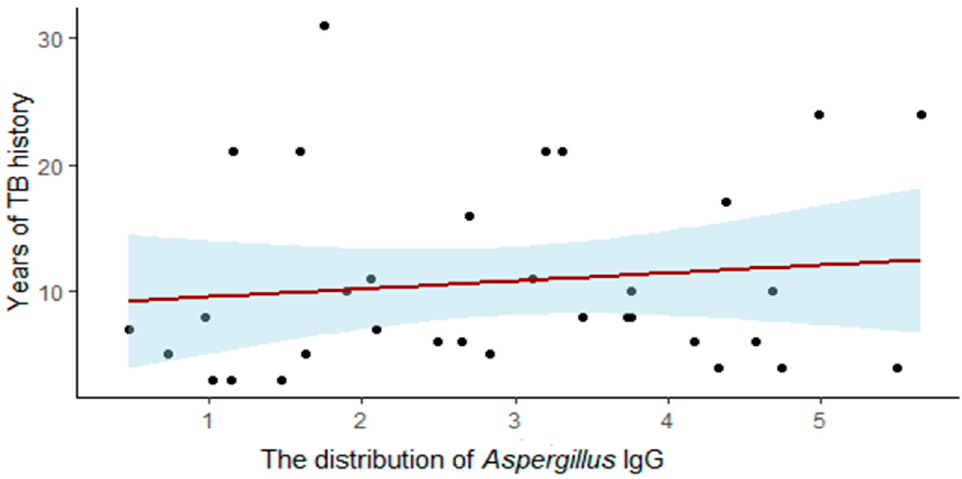
Figure 2. The correlation between Aspergillus IgG level and years of TB history.